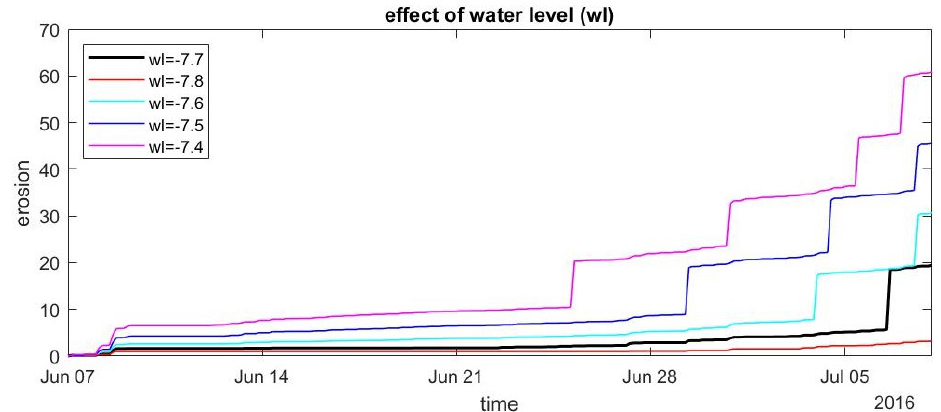
Figure 38. The effect of water level inputs on